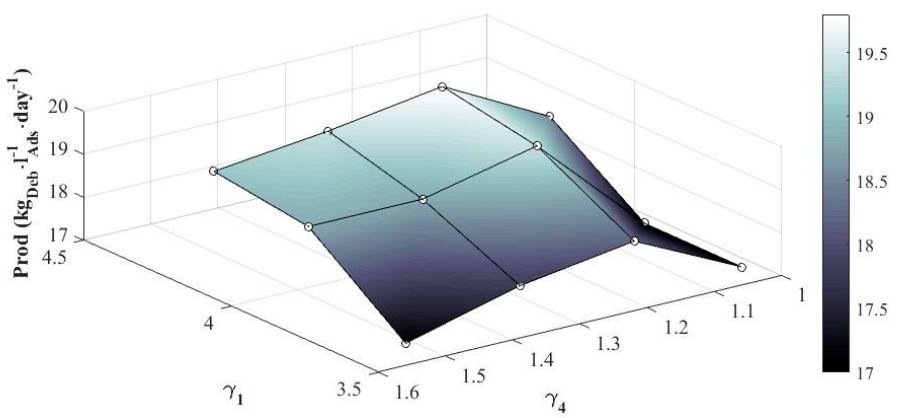
Figure 11. Productivity performance against γ 1 and γ 4 at the optimum γ 2 and γ 3.